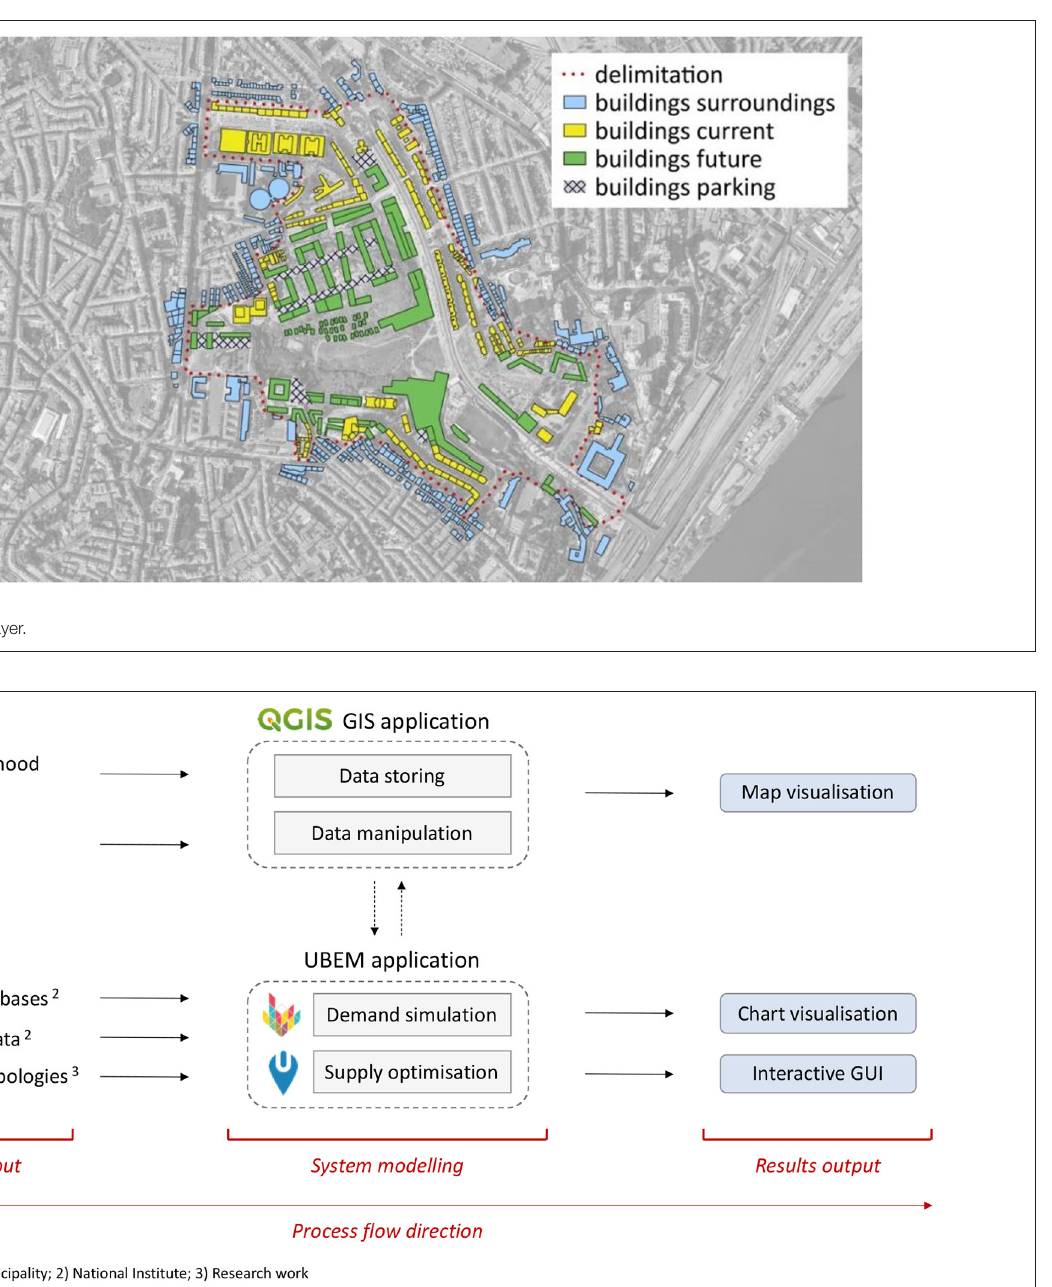
the envelope characteristics of the building, HVAC systems and their corresponding supply, while the occupancy